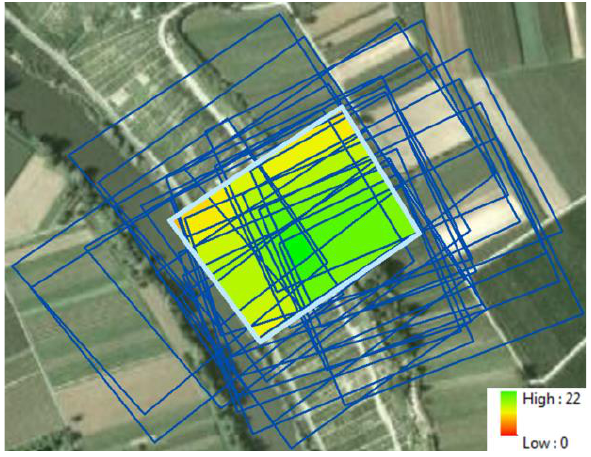
Figure 7: Amount of overlap for single